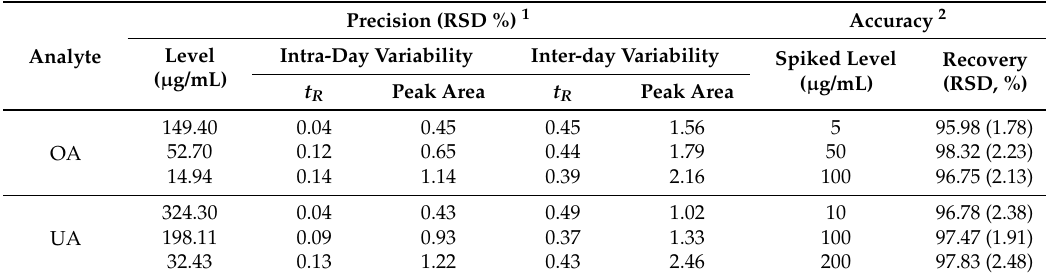
Table 6. Validation parameters of precision and